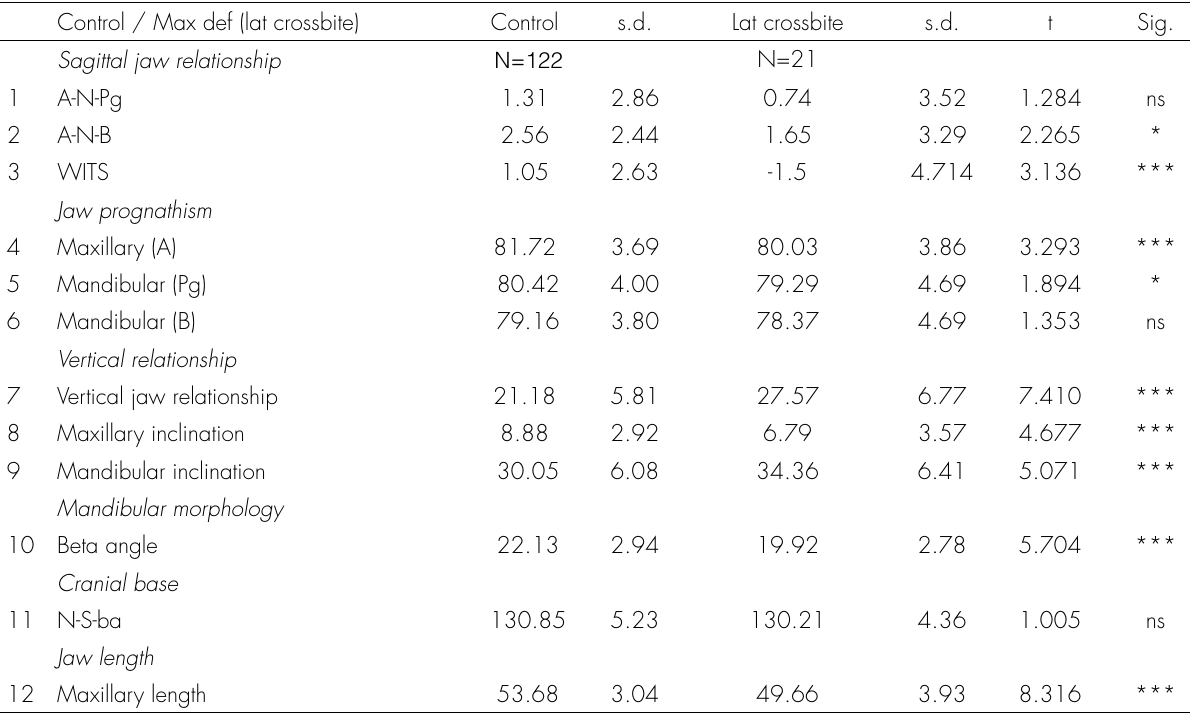
Table IIIe. Comparison between groups of the experimental material and the control material in terms of a lateral cross